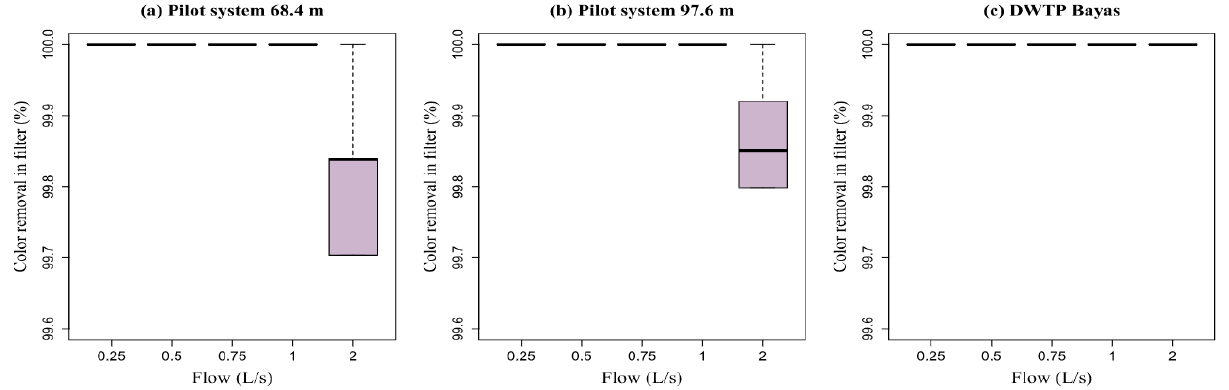
Figure 10. Color removal efficiency in the filter: ( a ) With HTF of 68.4 m, ( b ) with HTF of 97.6 m, and ( c ) in the filter of the DWTP “Bayas”.